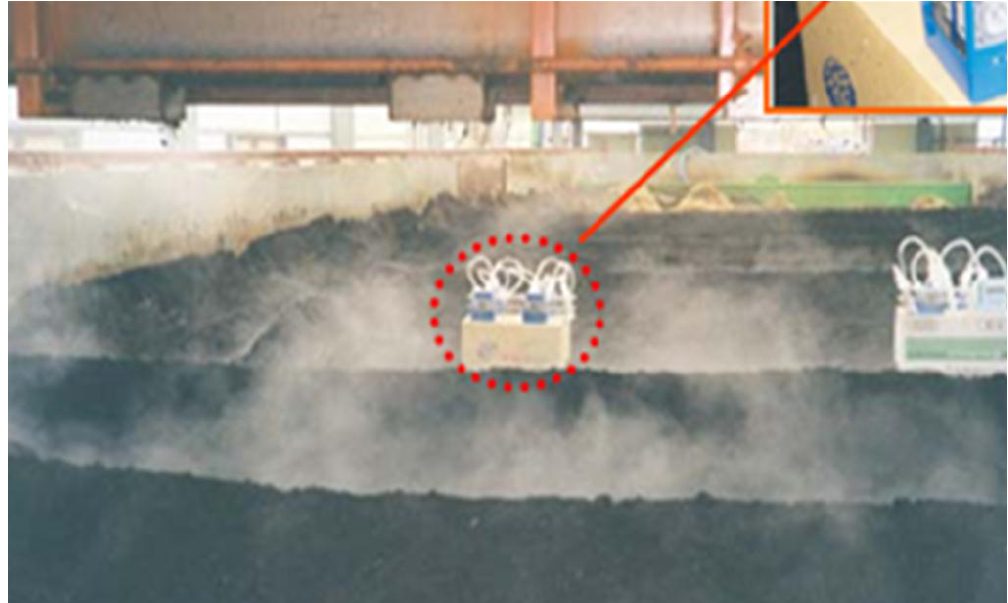
Figure 2. Collection of greenhouse gas samples at the composting facility for livestock excretions.